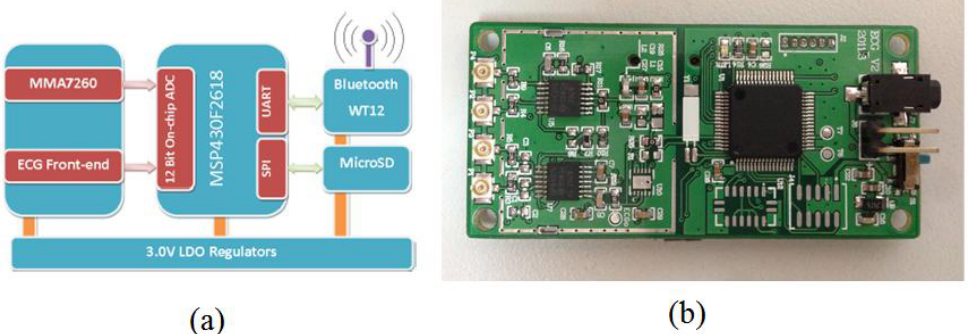
Figure 4. Diagram of the ECG sensor node and the ECG circuit